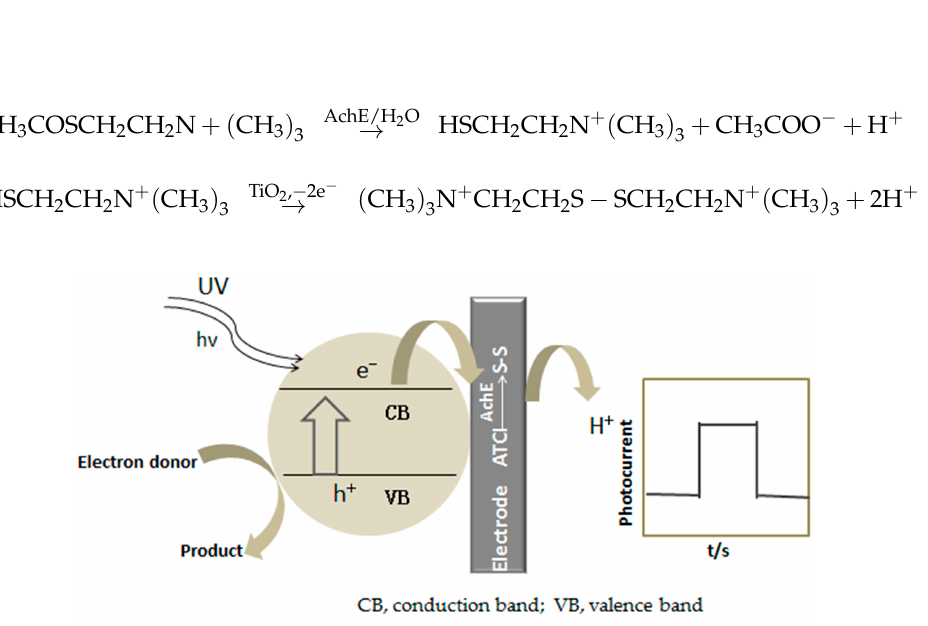
Scheme 1. The schematic diagram of the biosensor photoelectrochemical process.